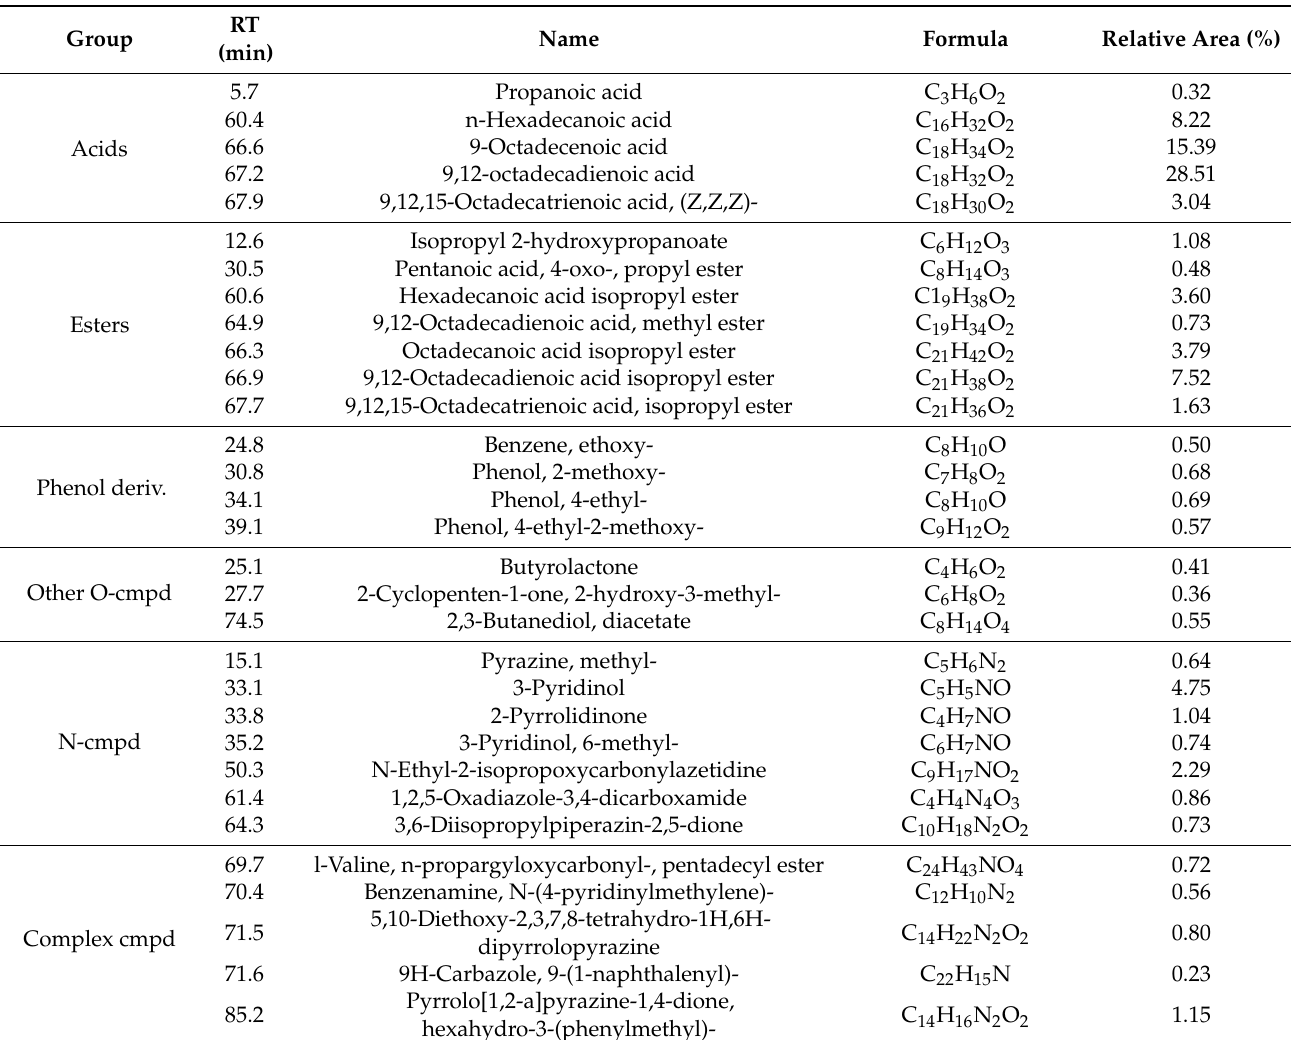
Table 3. Exemplary compounds identified in biocrude obtained from the conversion of blackcurrant pomace. RT Group (min)